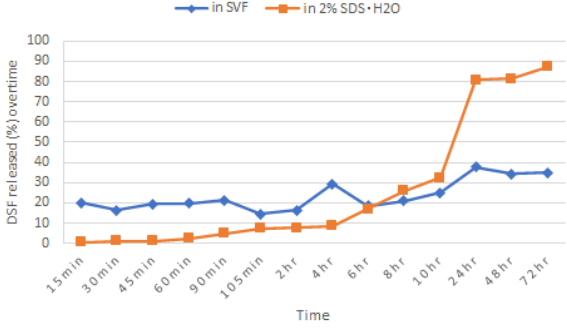
Figure 2. Comparison of cumulative DSF released from P70 formulation in different dissolution media.